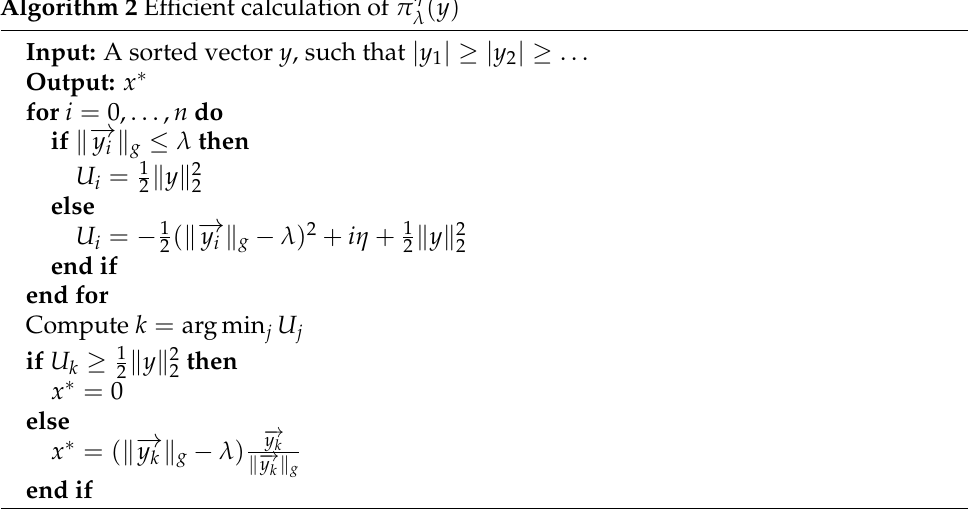
Algorithm 2 Efficient calculation of π η